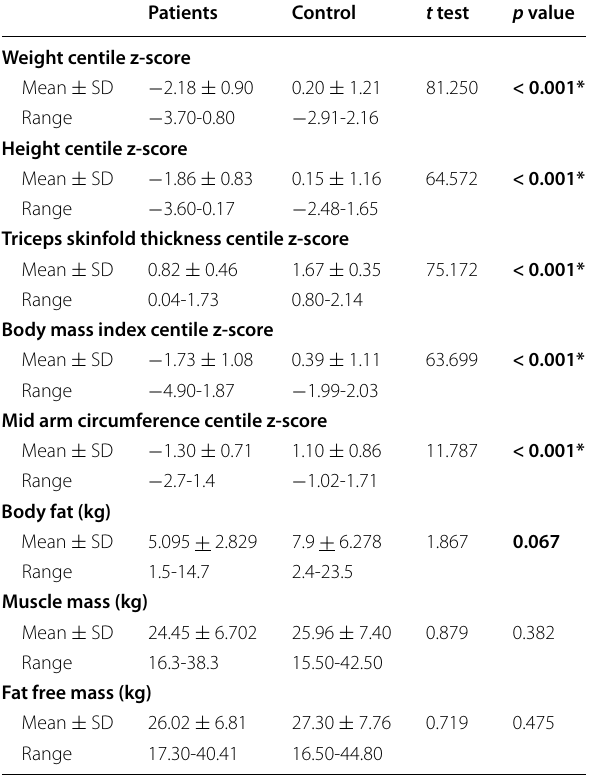
Table 2 Comparison between values of anthropometry and body composition components among patients and control groups